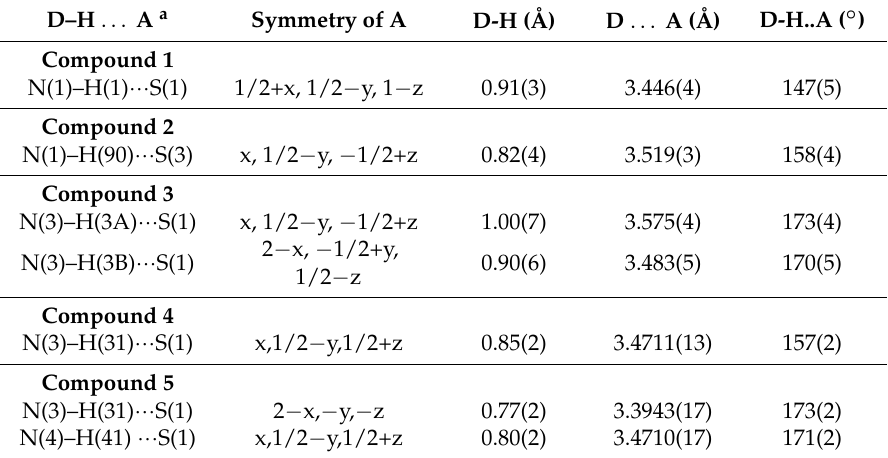
Figure 4. Perspective view of the dimeric compound 4 (60% probability ellipsoids). Symmetry code: (‘) 2 − x, − y, − z. Selected bond distances (Å) and angles (°): Cu(1)-N(1) 1.9487(13), Cu(1)-N(2)